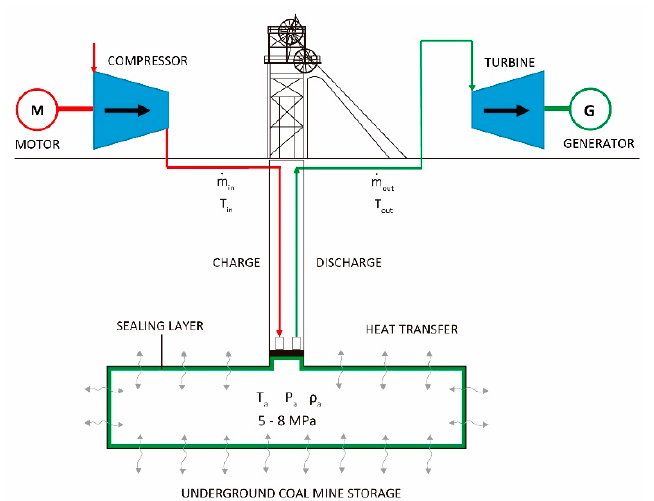
Figure 1. Schematic diagram of compressed air energy storage (CAES) system in abandoned un- derground mines. Compressor and turbine facilities installed on the surface and underground compressed air reservoir with an operating pressure range from 5 to 8 MPa.